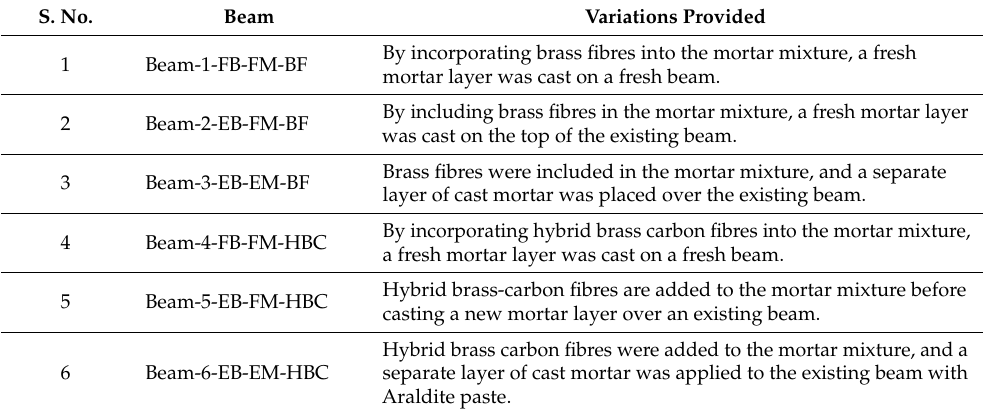
Table 3. Details of the beam